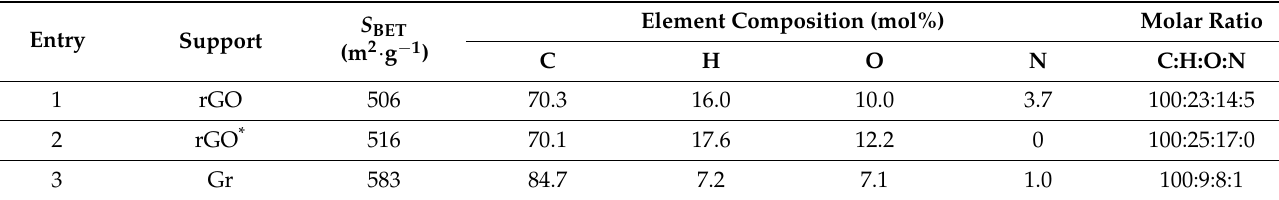
Table 1. Property of graphene materials.